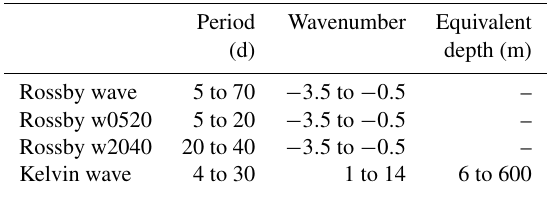
Table 1. Exact boundaries of the Rossby wave and Kelvin wave